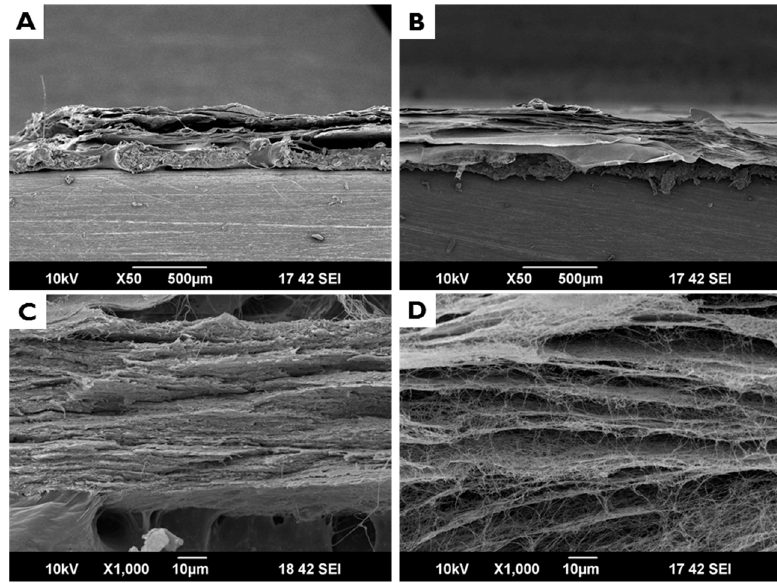
Figure 3. Cross sectional SEM images: ( A , C ) collagen membrane (CM); and ( B , D ) electron beam irradiated BC membrane (EI-BCM). EI-BCMs had a 3D structure cross-linked by nanofibers between each layers similar to the CM.